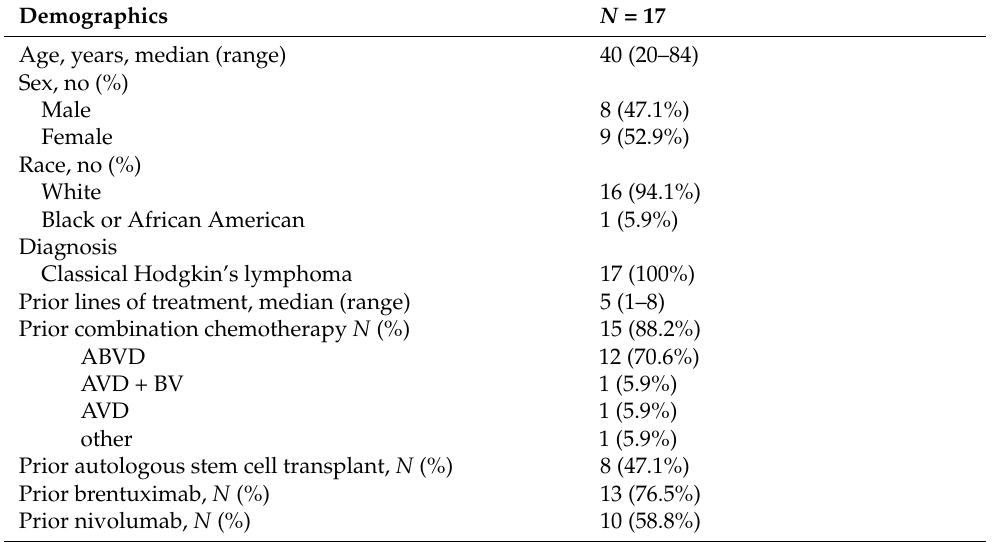
Table 1. Patient